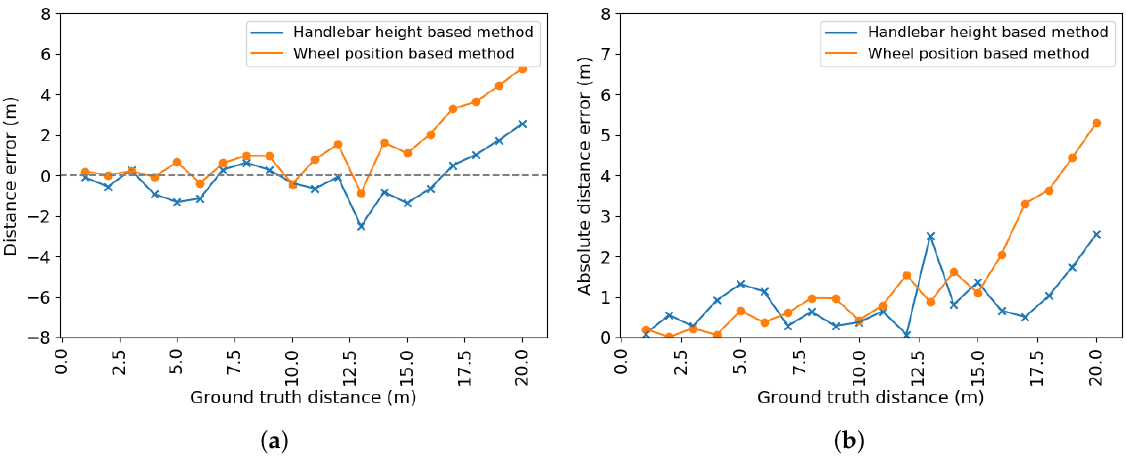
Figure 10. Error plots for the static test for both distance estimation methods. ( a ) Signed error; ( b ) absolute